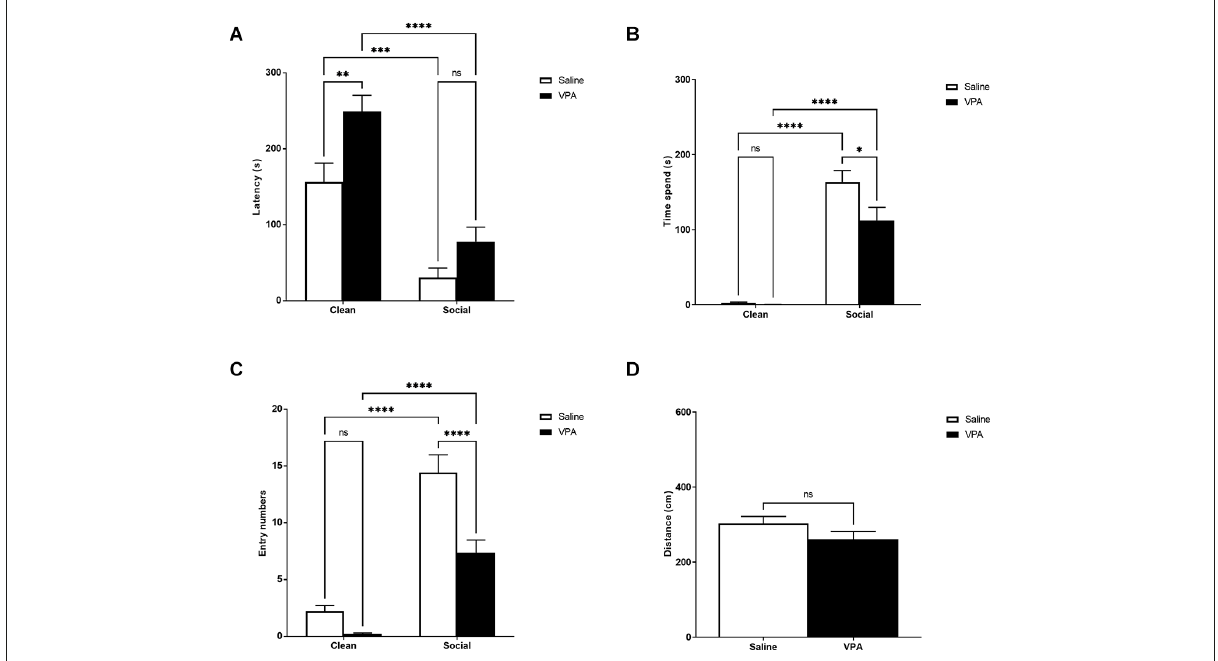
FIGURE1 (A) P6–7: latency to enter zones. Data expressed as mean ± standard error of the mean. We observed significant main effects of bedding type, p < 0.0001, and drug exposure, p = 0.007. VPA-exposed pups showed a longer latency to enter the clean bedding zone, p = 0.008. (B) P6–7: time spent in zones. Data expressed as mean ± standard error of the mean. We observed significant main effects of bedding type, p < 0.0001, drug exposure, p < 0.0001, and a significant interaction, p = 0.014. VPA-exposed pups spent significantly less time in the SB zone, p < 0.0001. (C) P6–7: number of zone entries. Data expressed as mean ± standard error of the mean. We observed significant main effects of bedding type, p < 0.04, drug exposure, p < 0.0001, and a significant interaction, p = 0.02. VPA-exposed pups made significantly fewer entries into the social bedding zone, p = 0.01. (D) P6–7: distance traveled during test. Data expressed as mean ± standard error of the mean. VPA-exposed pups did not differ from saline-exposed pups in their distance traveled during the test. ∗ p = 0.01–0.05; ∗∗ p = 0.001–0.01; ∗∗∗ p = 0.0001–0.001; ∗∗∗∗ p < 0.0001; ns = p >